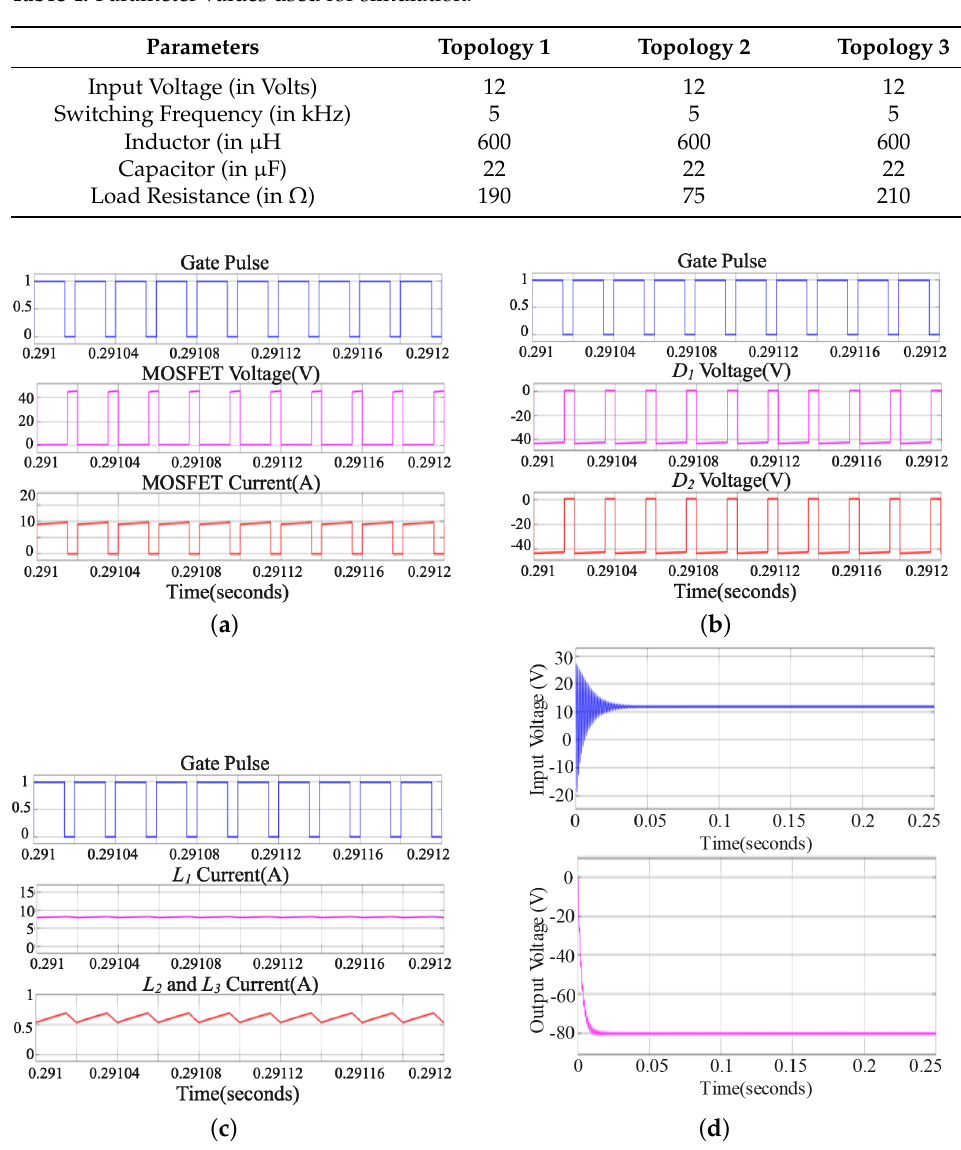
Figure 11. Simulation results of topology 2: ( a ) voltage and current of MOSFET ( b ) voltage across diodes ( c ) inductor’s current ( d ) input and output